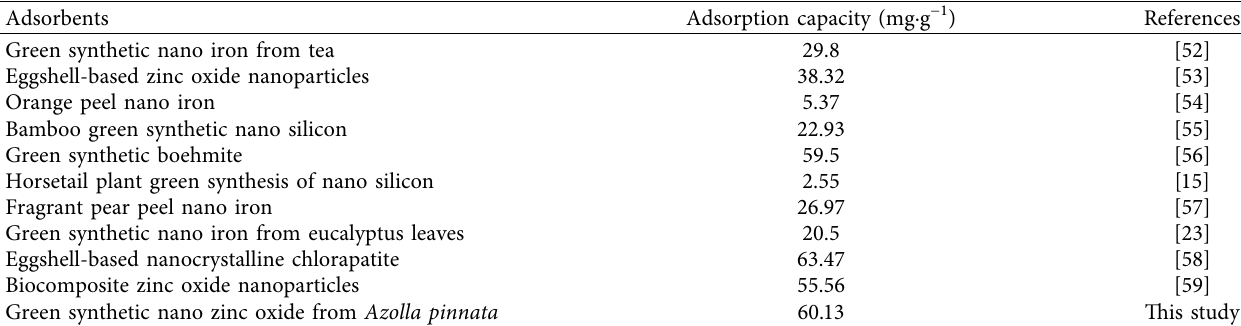
Table 2: Maximum adsorption capacities of reported nano sorbent for the removal of Cr ions.